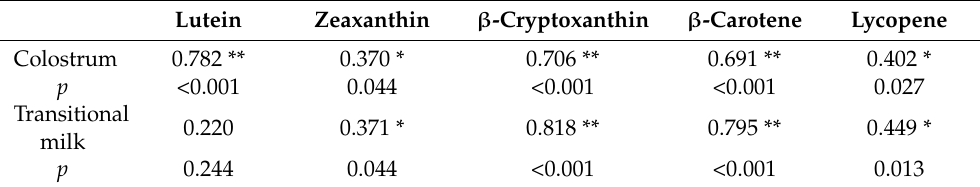
Table 4. Correlations of carotenoid levels in maternal plasma and human milk ( n = 30).